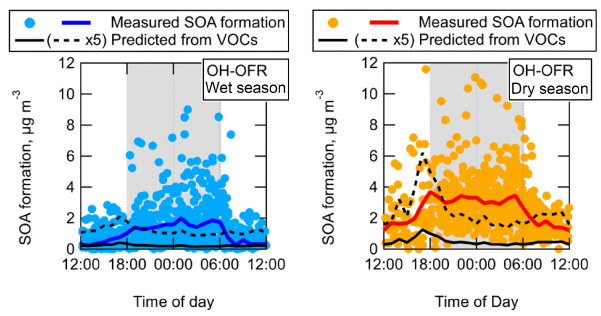
Figure 9. Measured SOA formation vs. local time of day and mean diurnal cycles of measured and predicted SOA formation, shown for OH oxidation during both wet and dry seasons. For clarity, the pre- dicted SOA from ambient VOCs is also shown multiplied by 5 for easier comparison of the trend relative to measured SOA